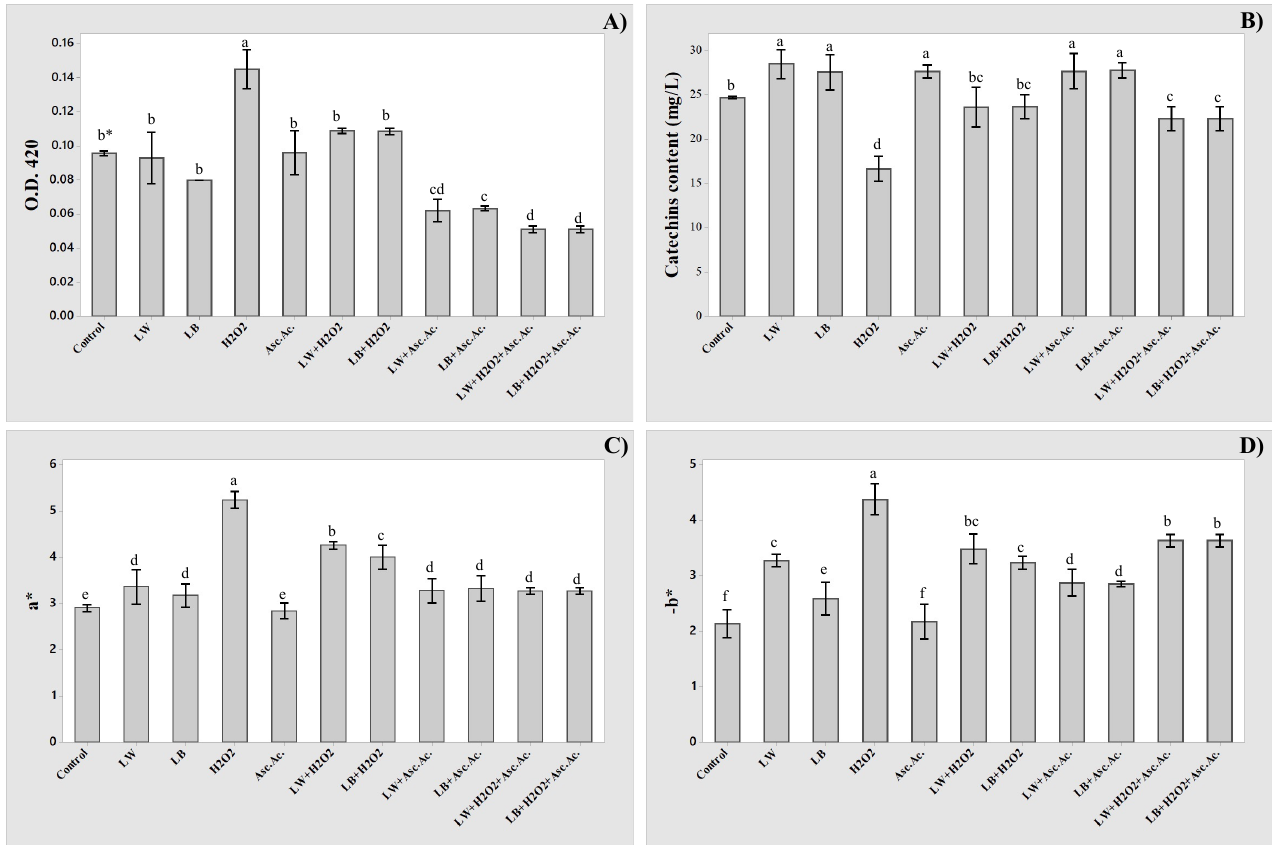
Figure 4. Results of OD420 ( A ), catechins ( B ), a* ( C ), and b* ( D ) before and after several chemical and light stresses.